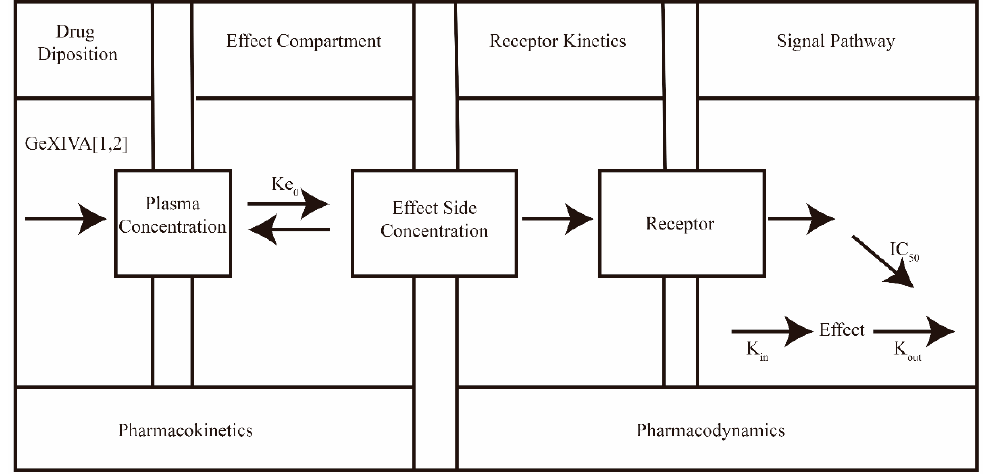
Figure 5. A schematic overview of the PK-PD model for GeXIVA[1,2]. GeXIVA[1,2] in plasma translocated to the effect side with the rate K e0 . After binding to the α 9 α 10 nAChR, downstream signalling pathways were affected, possibly resulting in an analgesic effect by inhibiting certain endogenous factors.